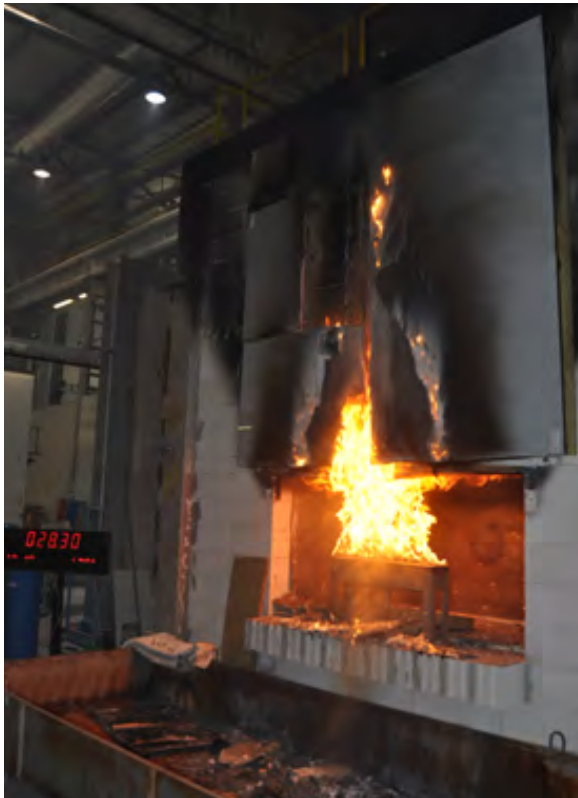
Figure 1: Example of fire test acc. to ITB